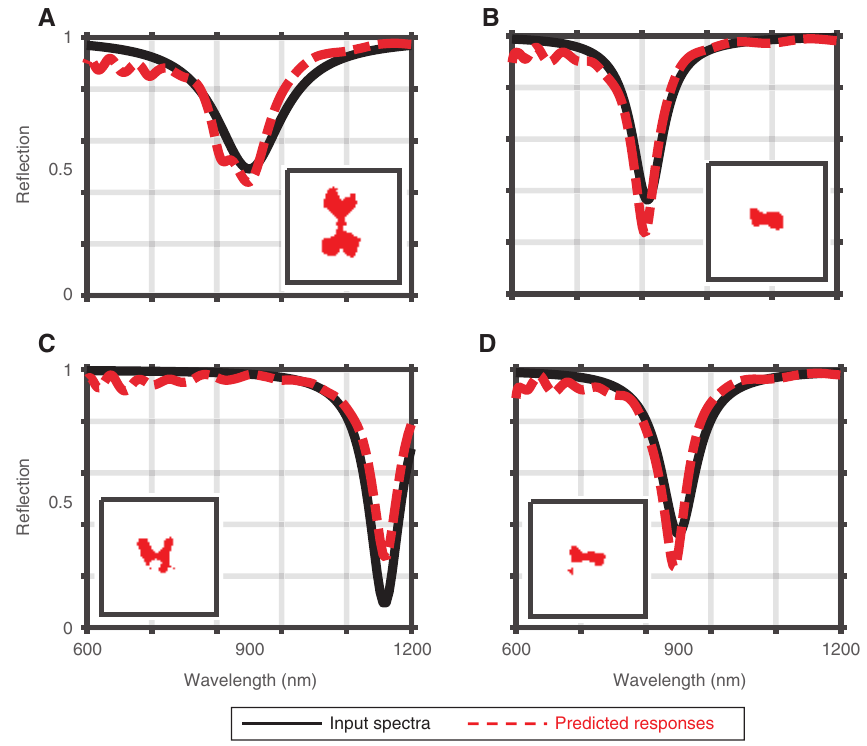
Figure 5: cDCGAN suggestion results of hand-drawn spectra. Lorentzian-like function of (A) a = 120, b = 900, c = 150, (B) a = 70, b = 850, c = 70, (C) a = 100, b = 1150, c = 70, and (D) a = 80, b = 900, c = 80. The inset in each figure shows the suggested PDFs by cDCGAN. Black solid lines indicate the input Lorentzian-like function that we fed to the network, and red dotted lines indicate the simulation results obtained from the suggested